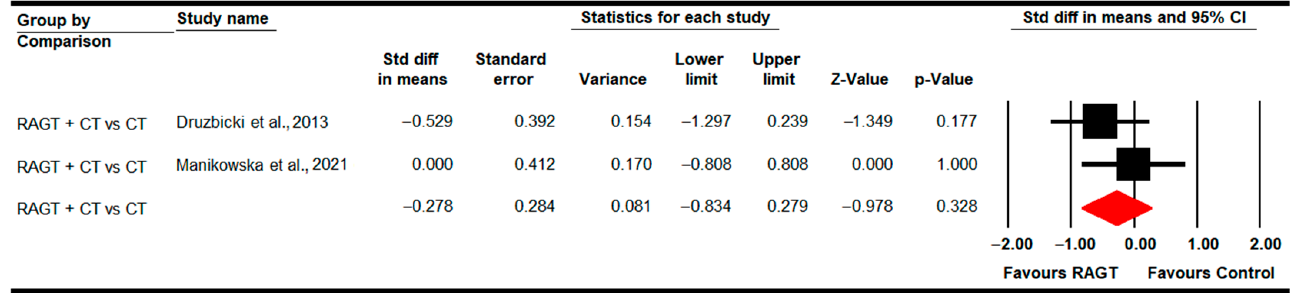
Figure 4. Forest Plot of Step width (Post-Intervention Assessment) [85,88].